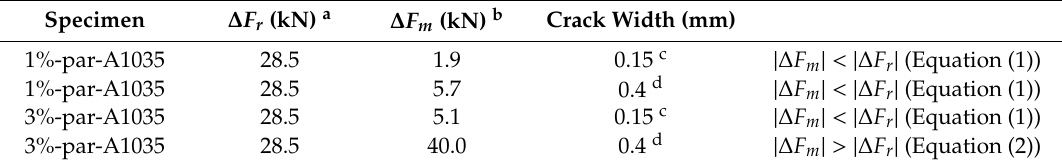
Table 4. Force mechanism for the stress versus strain response.